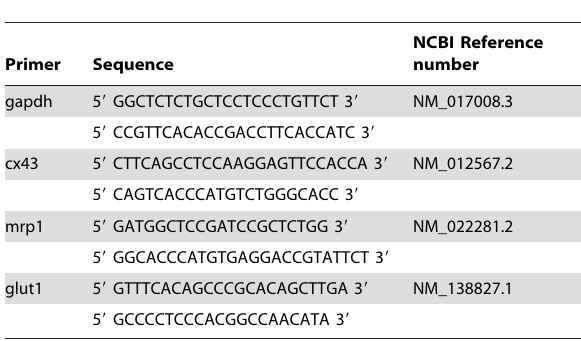
Table 1. Sequences of primers of gapdh, cx43, mrp1 and glut1.